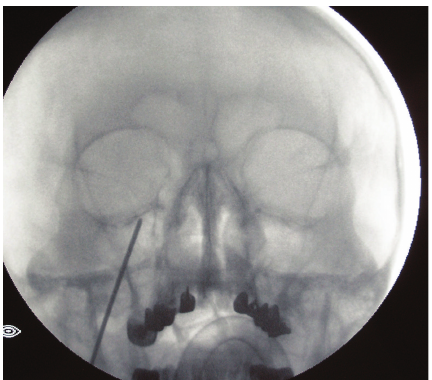
Figure 1: Through the entry point—2.5 cm lateral to the corner of the mouth, a specially designed needle with thin stylet was passed into foramen